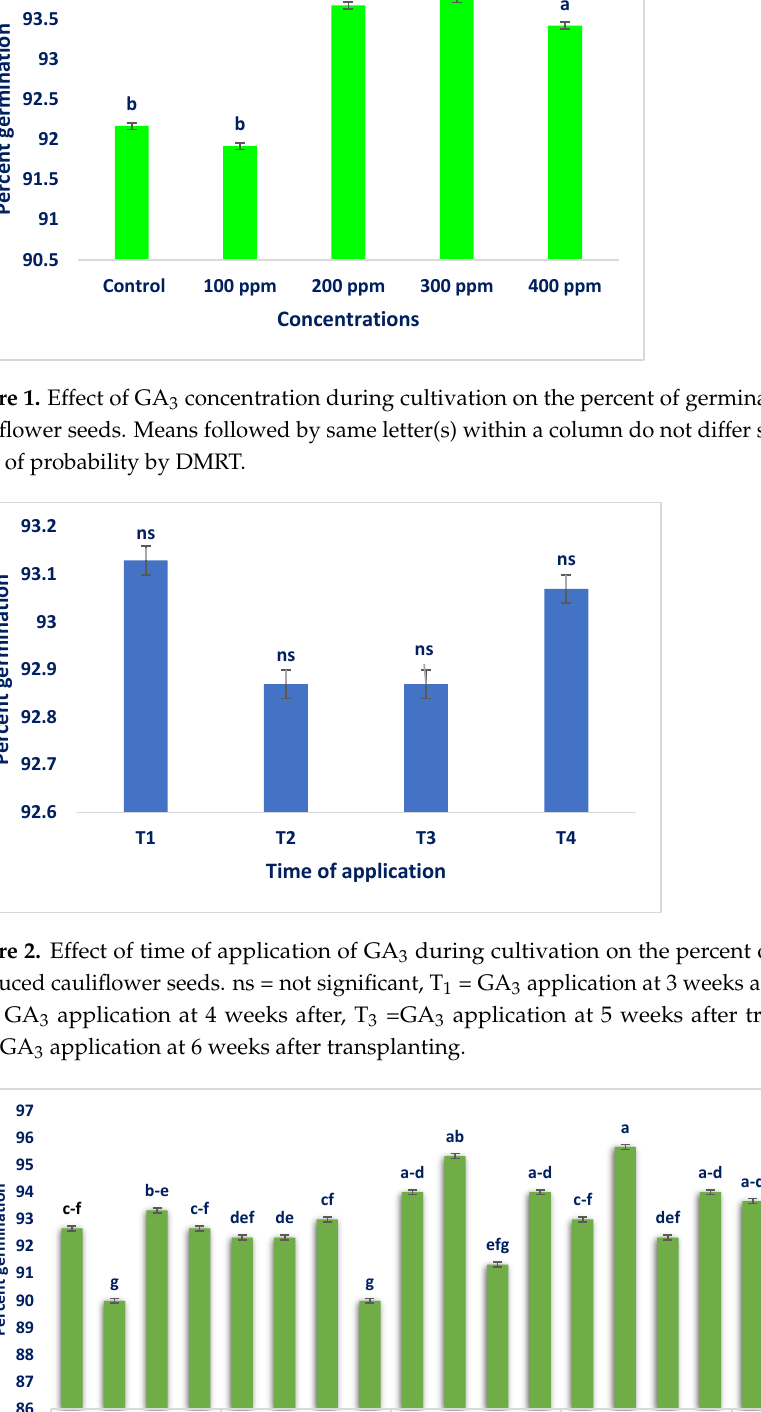
Figure 3. Interaction effect of GA 3 concentration and time of application during cultivation on the germination of produced cauliflower seeds. Means followed by same letter(s) within a column do not differ significantly at 5% level of probability by DMRT. T 1 = GA 3 application at 3 weeks after transplanting, T 2 = GA 3 application at 4 weeks after, T 3 =GA 3 application at 5 weeks after transplant- ing, and T 4 = GA 3 application at 6 weeks after transplanting.